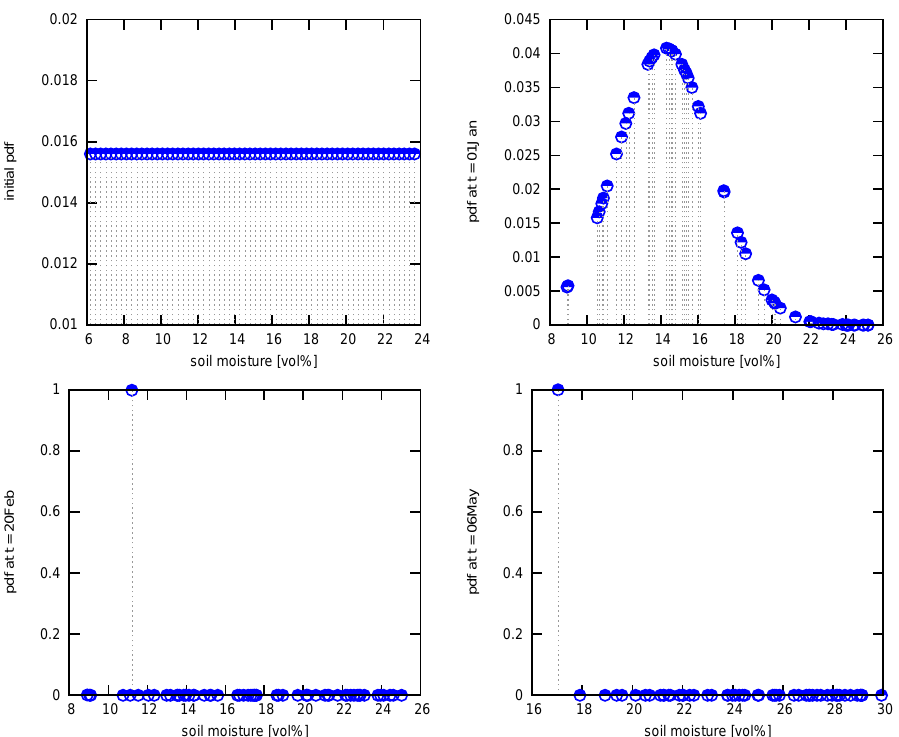
Fig. 2. Monitoring the importance weights: axis x represents the particles location (volumetric soil moisture [vol%]) and axis y the impor- tance weights values at four different daily model time steps 0, 1 (1 Jan), 51 (20 Feb), 126 (6